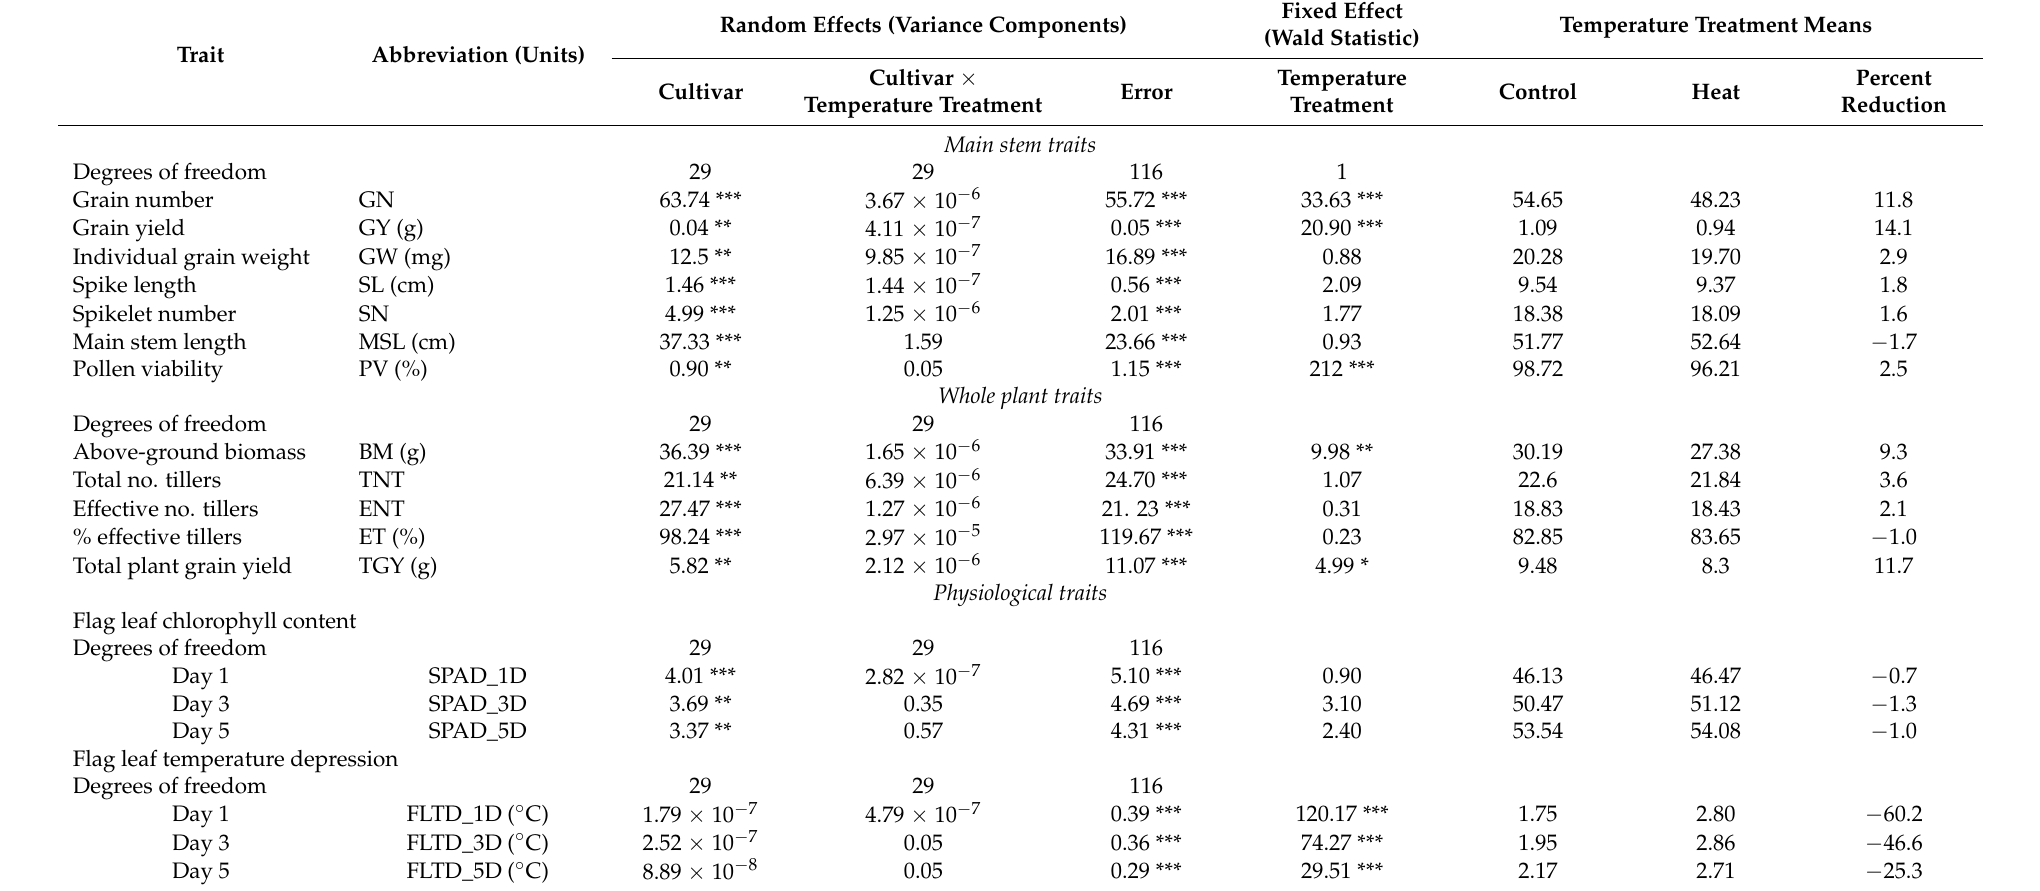
Table 1. The effect of cultivar and temperature treatment on various physiological and agronomic traits on the main stem and whole plants of 30 wheat genotypes exposed to 5 d of high temperature (“Heat”) or control temperature (“Control”) treatments during meiosis. The significance of variance components was evaluated by a one-tailed Z-test, and significance of temperature treatment (fixed effect) by the Wald statistic. Percent reduction in the high temperature treatment means is expressed relative to the control, and positive values indicate that the high temperature treatment means are lower than the control treatment. Individual cultivar means under high temperature and control treatments are provided in Supplementary Table